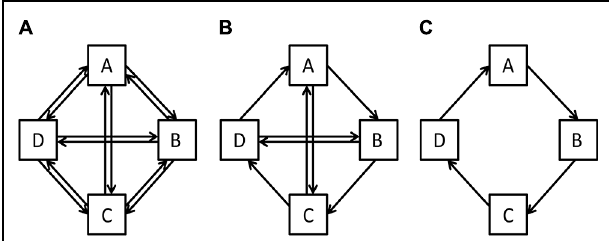
FIGURE 2 | Schematic of three idealized self-sustaining networks to illustrate the different degrees to which energy/meaning is coupled among components. (A) Highly redundant system (yielding disorder). (C) Highly efficient system (yielding order). (B) System with intermediate recycling efficiency (adapted from Ulanowicz,